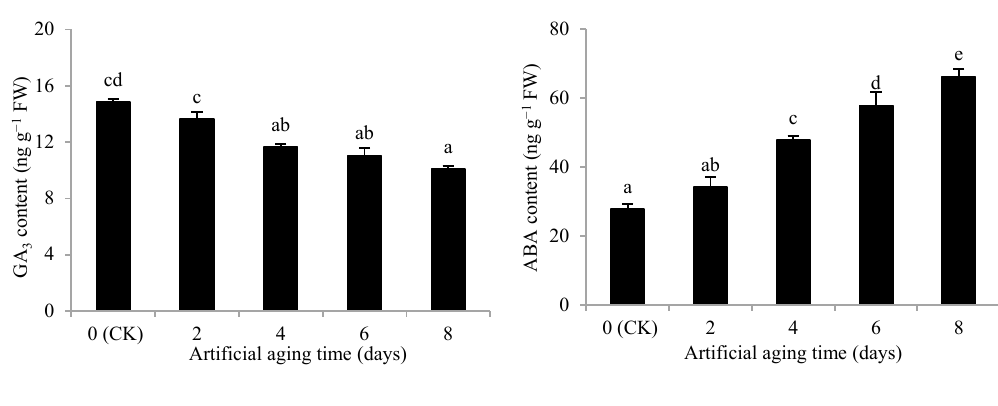
) and abscisic acid (ABA) content of Aegilops tauschii seeds. 3